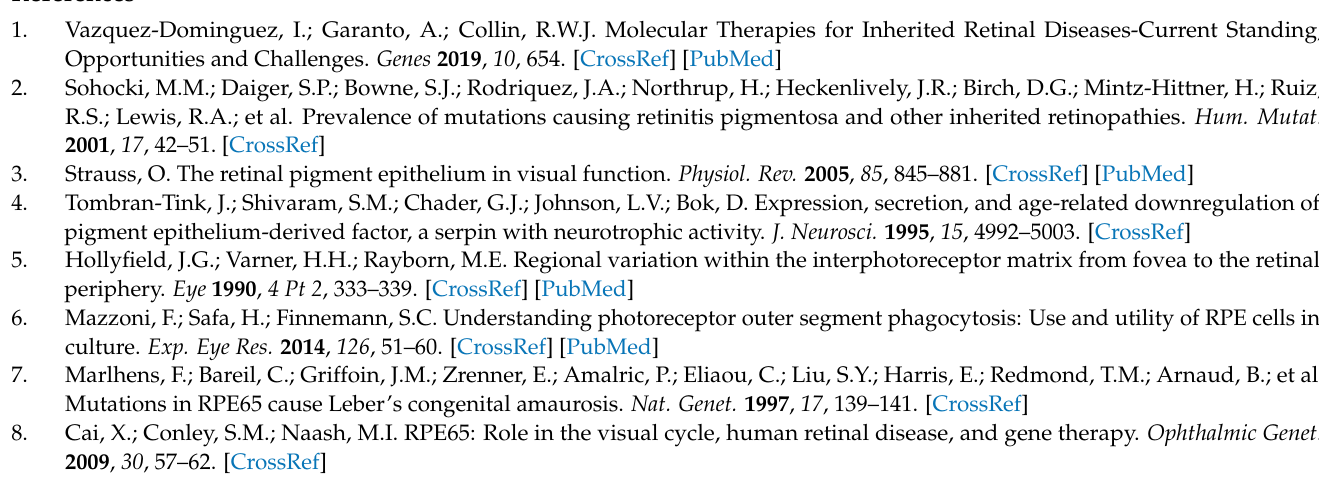
work; Table S2: List and combinations of antibodies used for immunocytochemistry; Table S3: list of antibodies used for Western blot analysis study; Table S4: Summary of the protein analysis of the ~35 kDa and 65 kDa protein band from the IP of RPE65; Figure S1: Peptide coverage of RPE65 in for the 65 kDa band; Figure S2: RT-PCR from exon 1 to 3 of the RPE65 entry clones in different cell